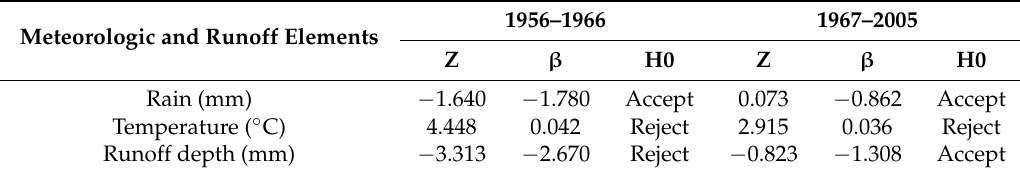
Figure 2. Mann–Kendall results of: ( a ) Annual runoff; ( b ) precipitation; and ( c ) temperature, in the upper Naoli River watershed during 1956–2005. Table 1. Statistic values of runoff and meteorological elements in the upper Naoli River watershed.